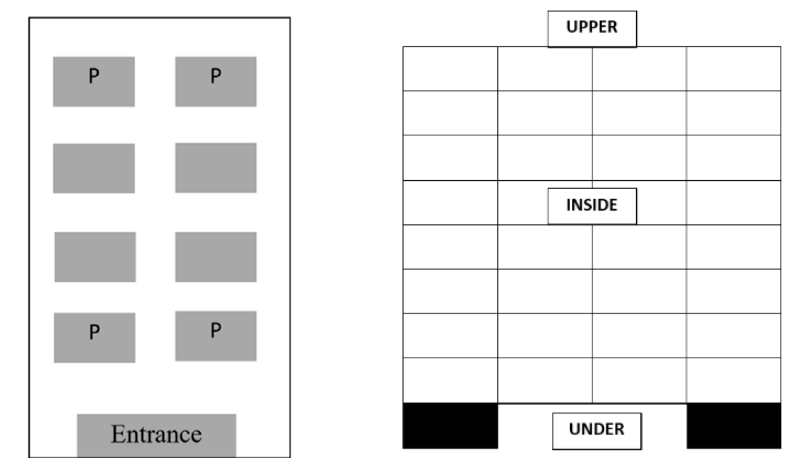
Figure 1. Distribution of the pallets ( left ) inside the chamber (with «P» are the pallets in which insect vials were placed) and locations in each pallet in which vials with insects were placed (upper, inside and under the pallet). Black color indicates the legs of the pallet ( right ). Table 1. Distribution of the vials with insects in the pallets (at the center of the pallets, at the upper part of the pallets and under the pallets), along with the conditions for each trial. Locations were slightly varied from trial to trial based on accessibility